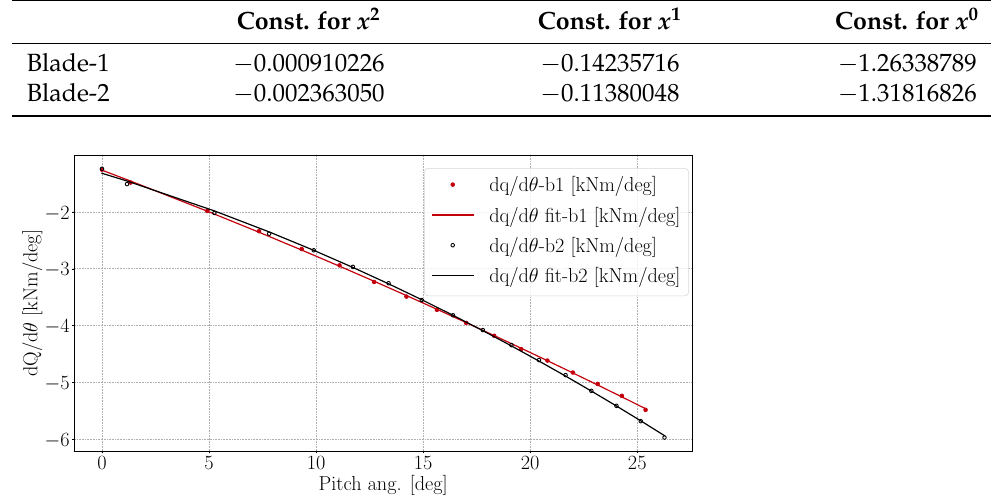
Figure 6. Aerodynamic gains for both blades (blade-1 (b1: red symbol and line), blade-2 (b2: black symbol and line)) and their second order polynomial fit from